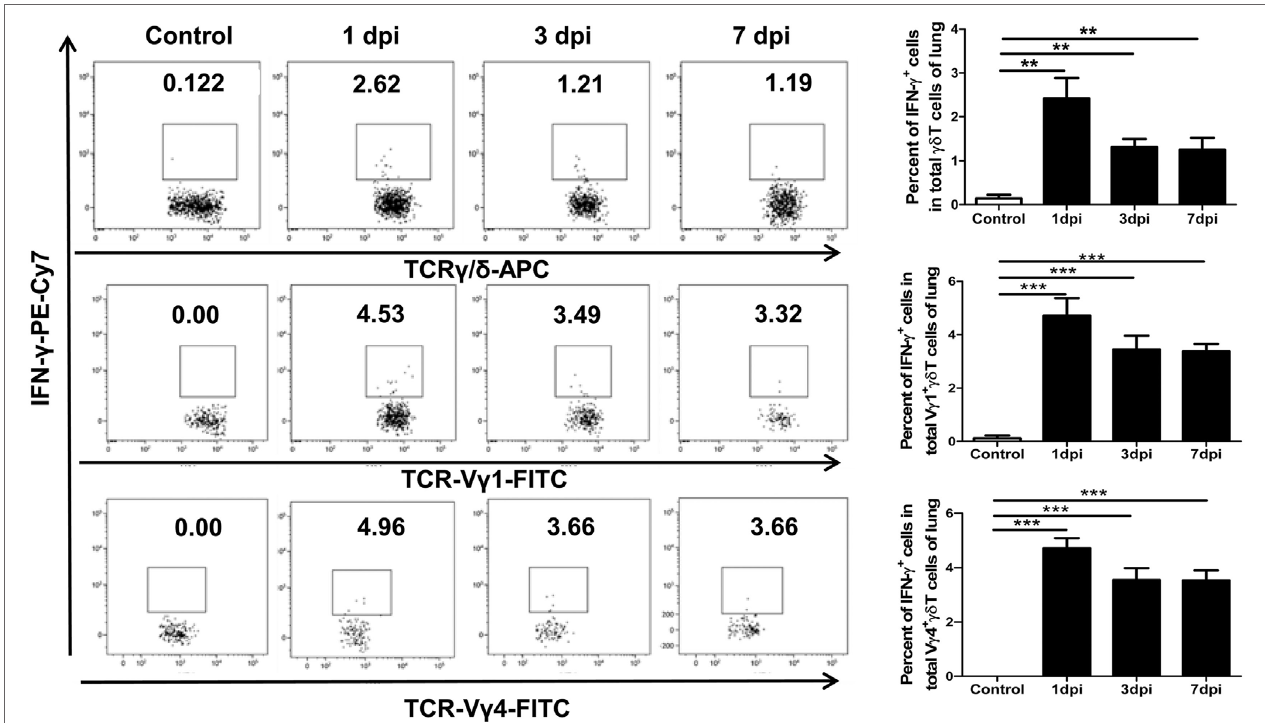
FigUre 5 | Expression of IFN- γ by γδ T cells and V γ 1 + γδ T or V γ 4 + γδ T subset at different dpi in the lungs. The stained lung lymphocytes were first gated on CD3 + T cells, and then, the expression of IFN- γ in γδ T cells (upper) in the control or infected lungs at the indicated dpi were analyzed. The expression of IFN- γ in the V γ 1 + γδ T (middle) and V γ 4 + γδ T (lower) subsets was first gated on CD3 + γδ TCR + cells. The numbers represent the proportion of IFN- γ -positive cells among the different subsets at the indicated dpi. Histogram showing the statistical analysis of the proportion of different subsets in the control or infected lungs at different dpi. The results are representative of two independent analyses ( n = 3 for each group). ** p < 0.01, *** p <